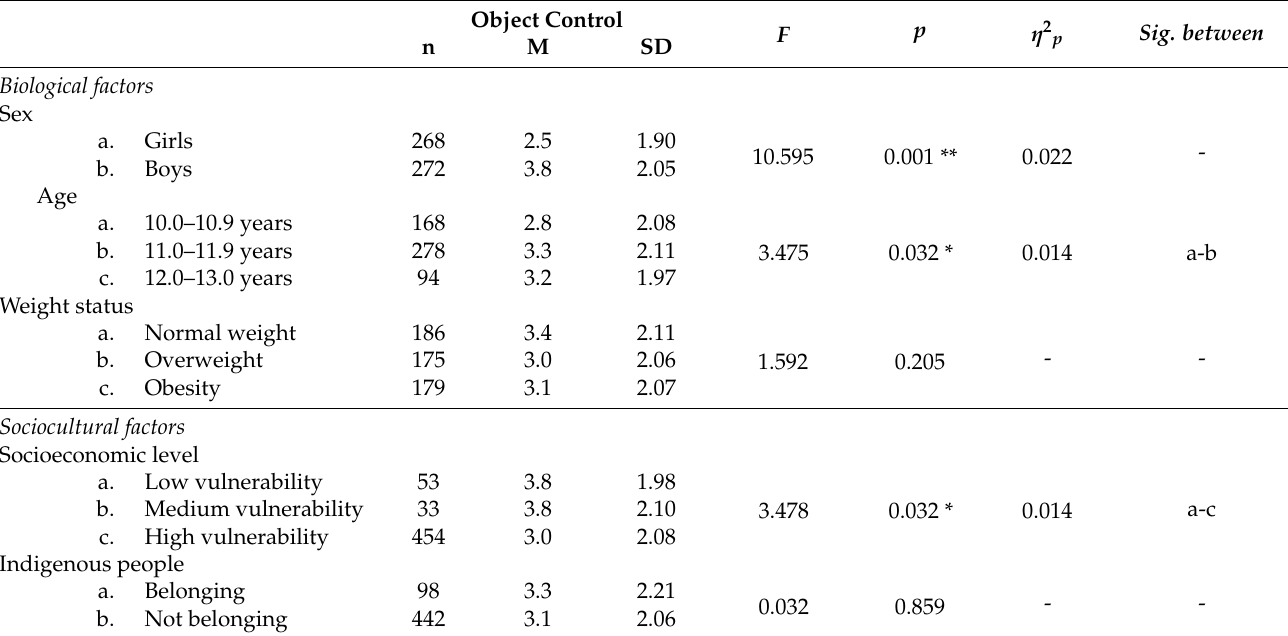
Table 2. Results for the object control domain according to sex, age, weight status, socioeconomic level and belonging or not belonging to an indigenous